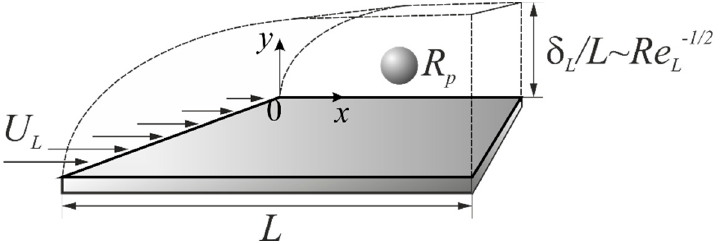
Figure 1. Sketch of a spherical particle with radius R p in the boundary layer (BL) at a plate with length L ; δ L is the characteristic thickness of BL.